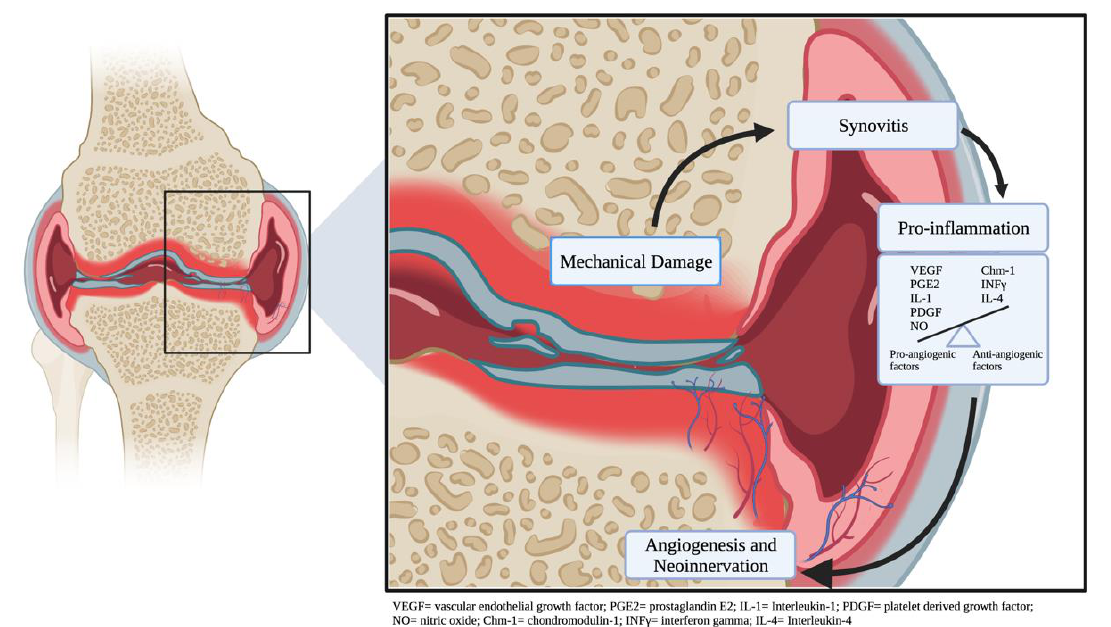
Figure 1. Understanding of the balance between pro and anti-angiogenic cytokines, inflammatory biomarkers.